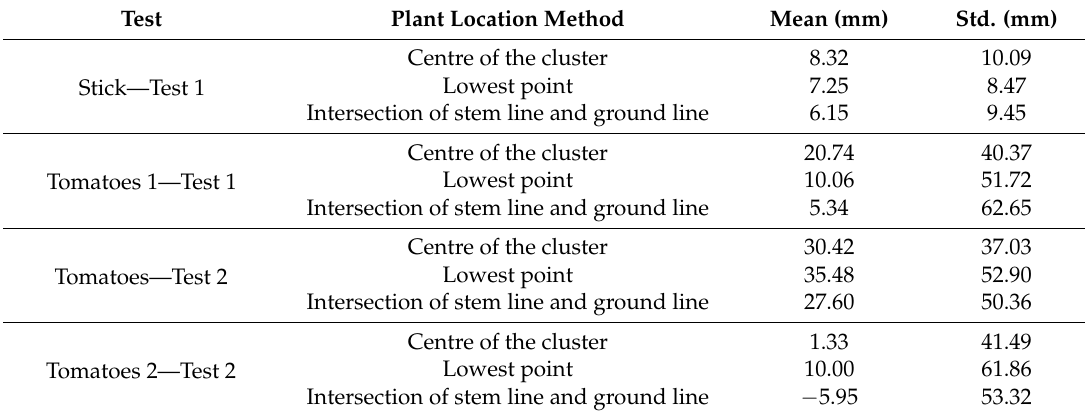
Figure 11. Plant location method based on the intersection of stem line and ground line. ( a ) Intersection point between the average aerial part of the plant line (green line) and the average ground line (red line); ( b ) Intersection point between the stick aerial part line (green line) and the ground line (red line). Both histograms of aerial part of the plant points are shown on the bottom. Table 9. Mean and standard deviation (Std.) of the plant and stick locations during the tests.